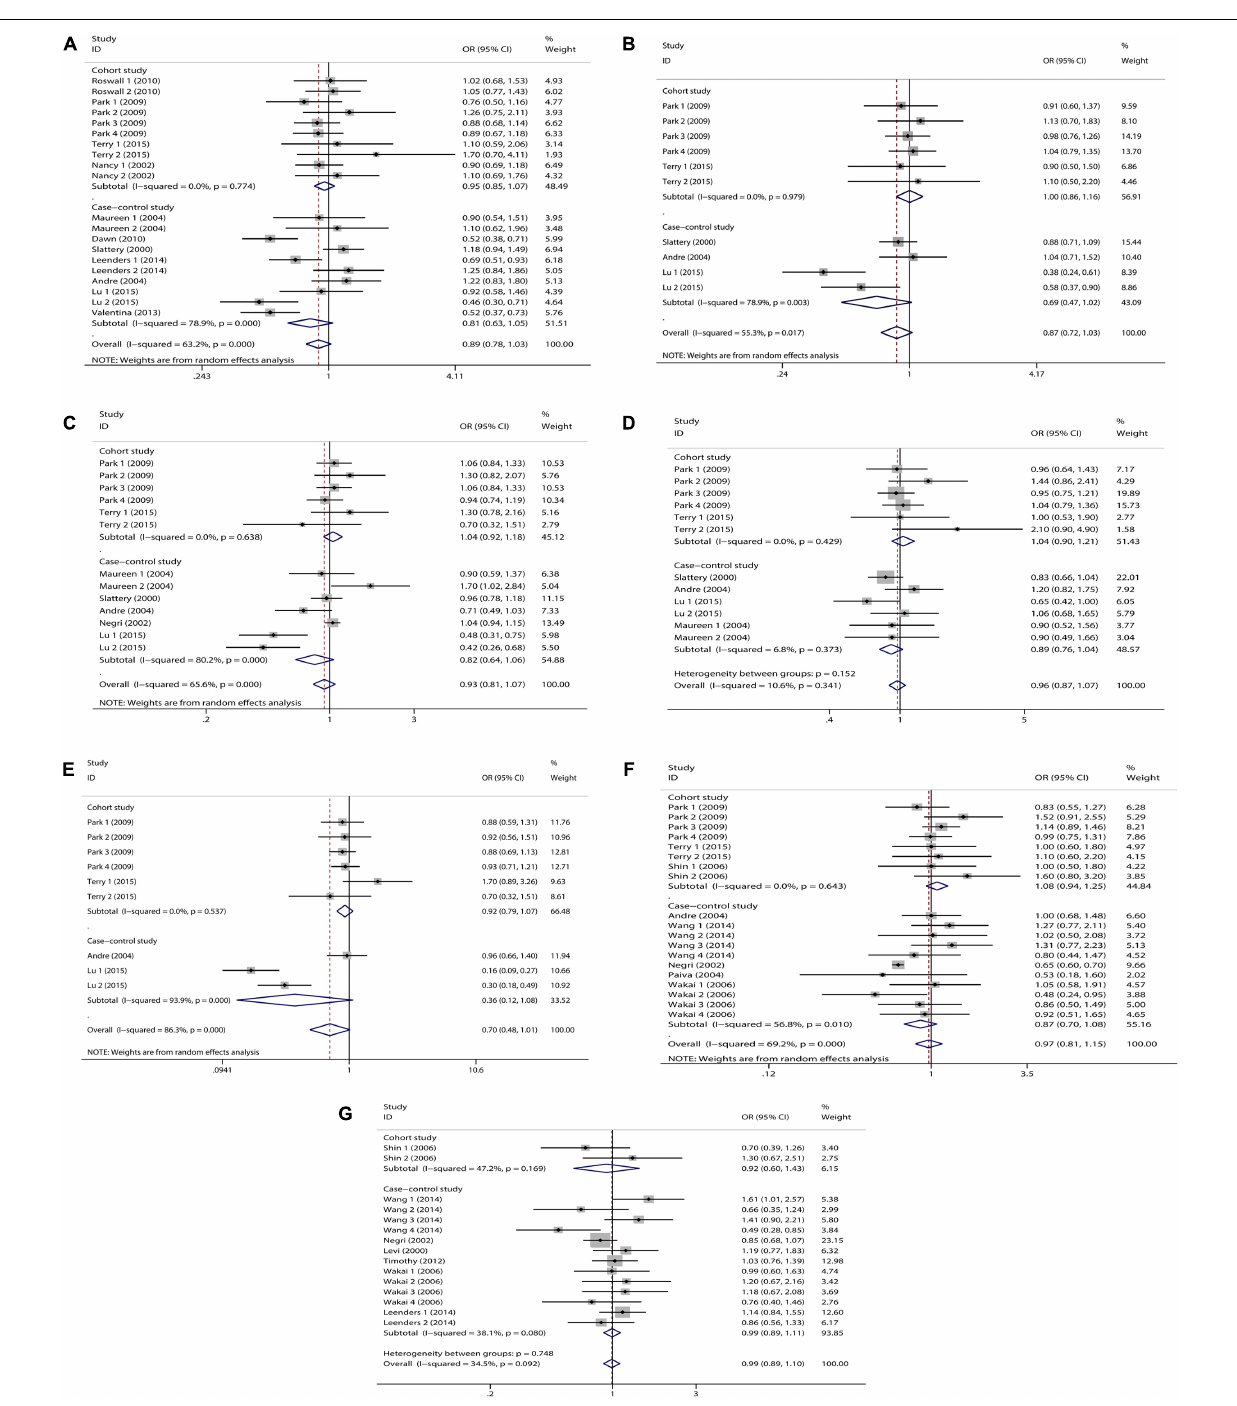
slightly, but not significantly ( p t = 0.329), reduced CRC